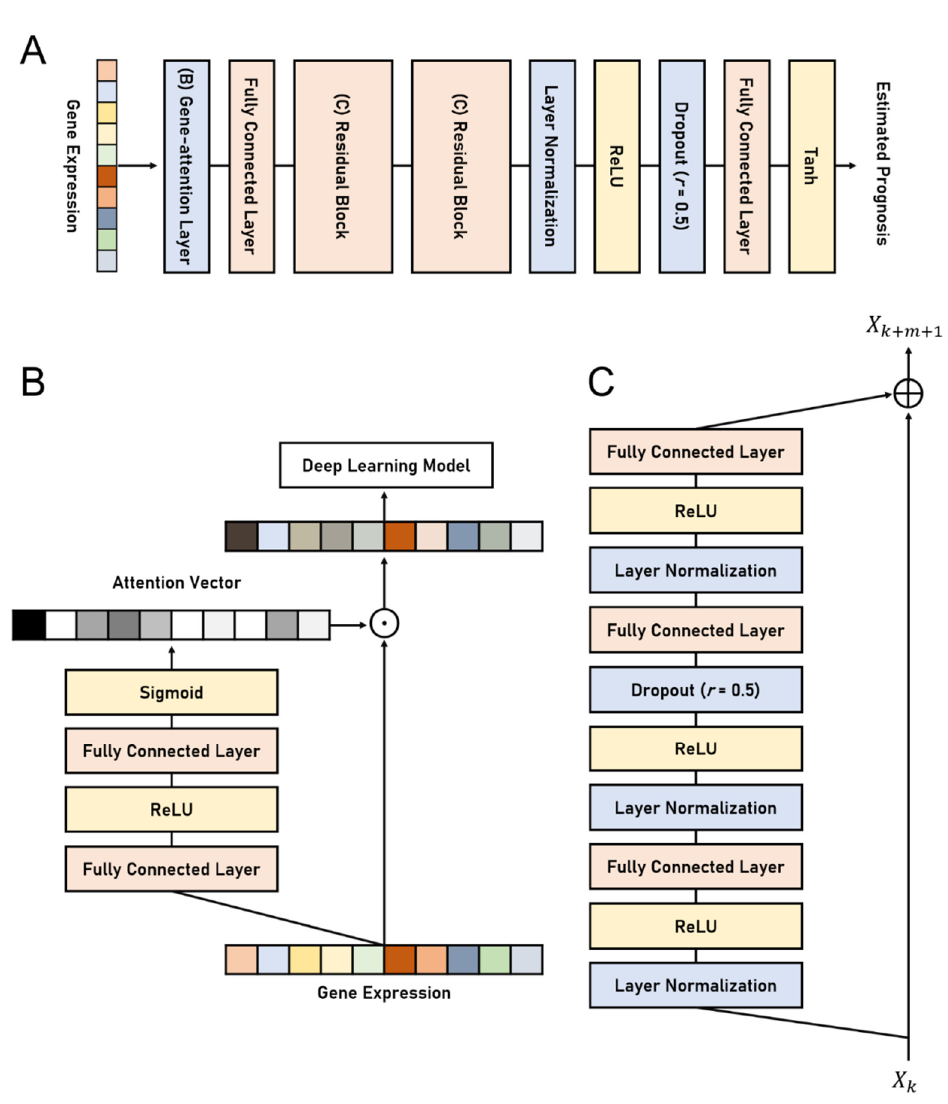
Figure 1. The architectures of the GAENET. ( A ) The architecture of a sub-model in the GAENET. ( B ) The proposed gene attention layer. ( C ) Residual block in the sub-model. The gene attention layer and residual blocks in ( A ) are illustrated in ( B ) and ( C ), respectively. Each purpose of the process is indicated by its color: Orange denotes a deep learning layer; yellow denotes an activation function; blue denotes regularization methods for layer outputs. The GAENET is composed of an ensemble of n number of the sub-models in ( A ), whereas the models share the gene attention layer. The r in the dropout layers indicates the dropout rate.